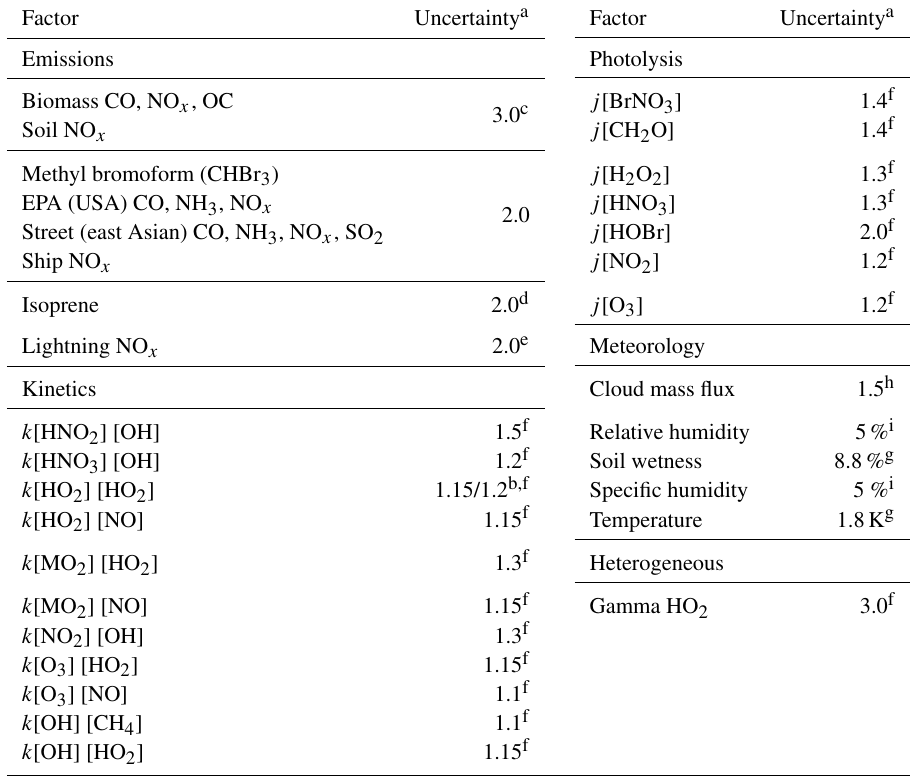
Table 1. Factors included in INTEX-A random sampling – high dimensional model representation (RS-HDMR) analysis and their respec- tive uncertainties. OC is organic carbon, MP is methyl hydroperoxide, and MO 2 is methyl peroxy radical. Uncertainties are expressed as multiplicative factors, except as noted in meteorological